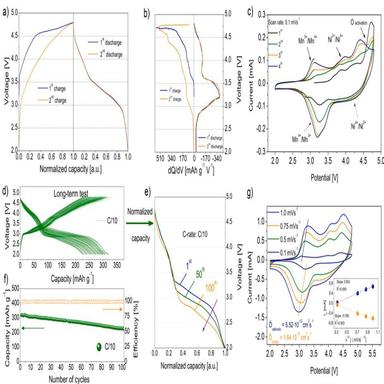
a) The normalized voltage profiles and b) the corresponding dQ/dV plots for the 1st and 2nd cycles at a current rate of C/20 for LiO2; c) cyclic voltammograms of LiO2 with 0.1 mVs− 1 scan rate; d) voltage profiles as a function of specific capacity for a long-term test at C/10 current rate with e) selected profiles as a function of normalized capacity as well as f) columbic efficiency and discharge capacities of the Li/Li+/LiO2 cell as a function of cycle number for a long- term test under C/10 current rate